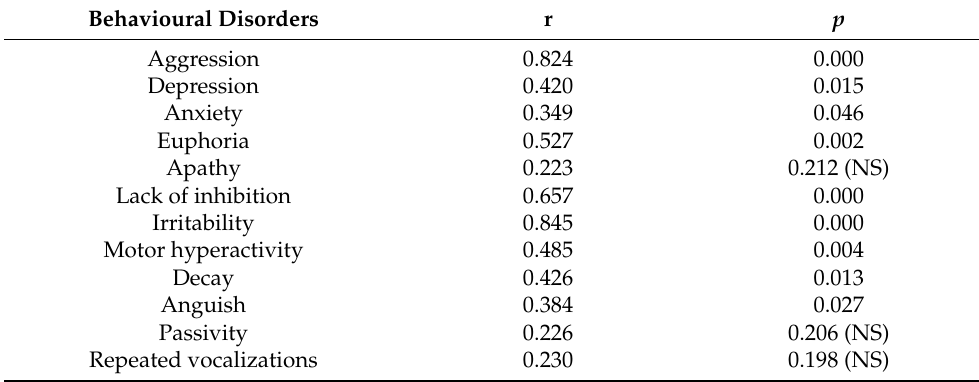
Table 10. Correlations between Abuse and behavioural